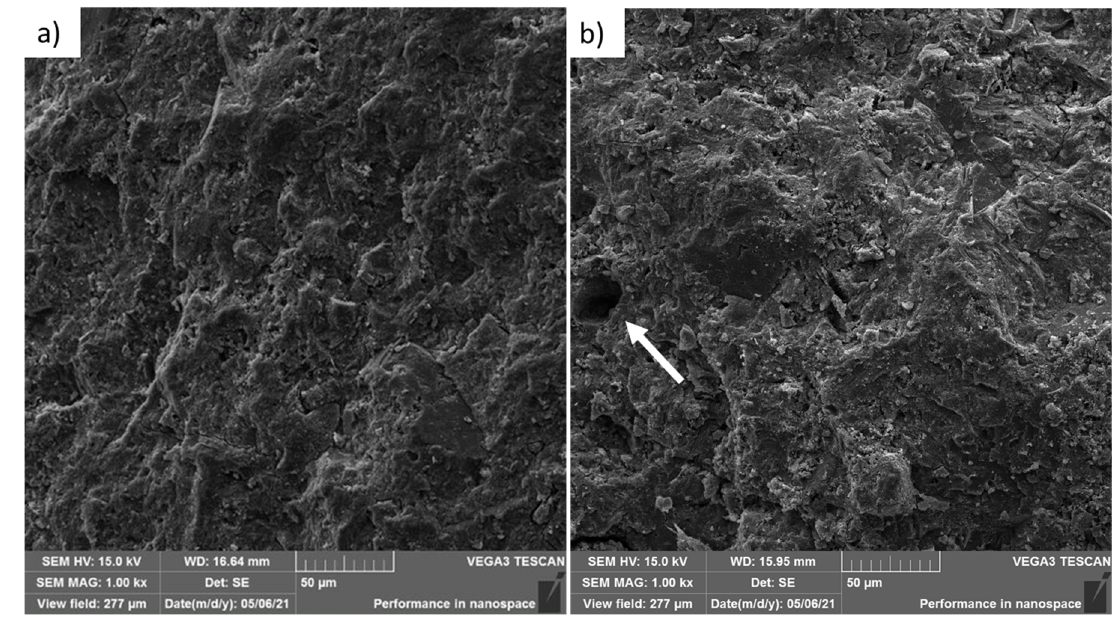
Figure 6. SEM images of cement pastes after 28 days: ( a ) 0.0% CNT and ( b ) 0.1% CNT (1000 ×